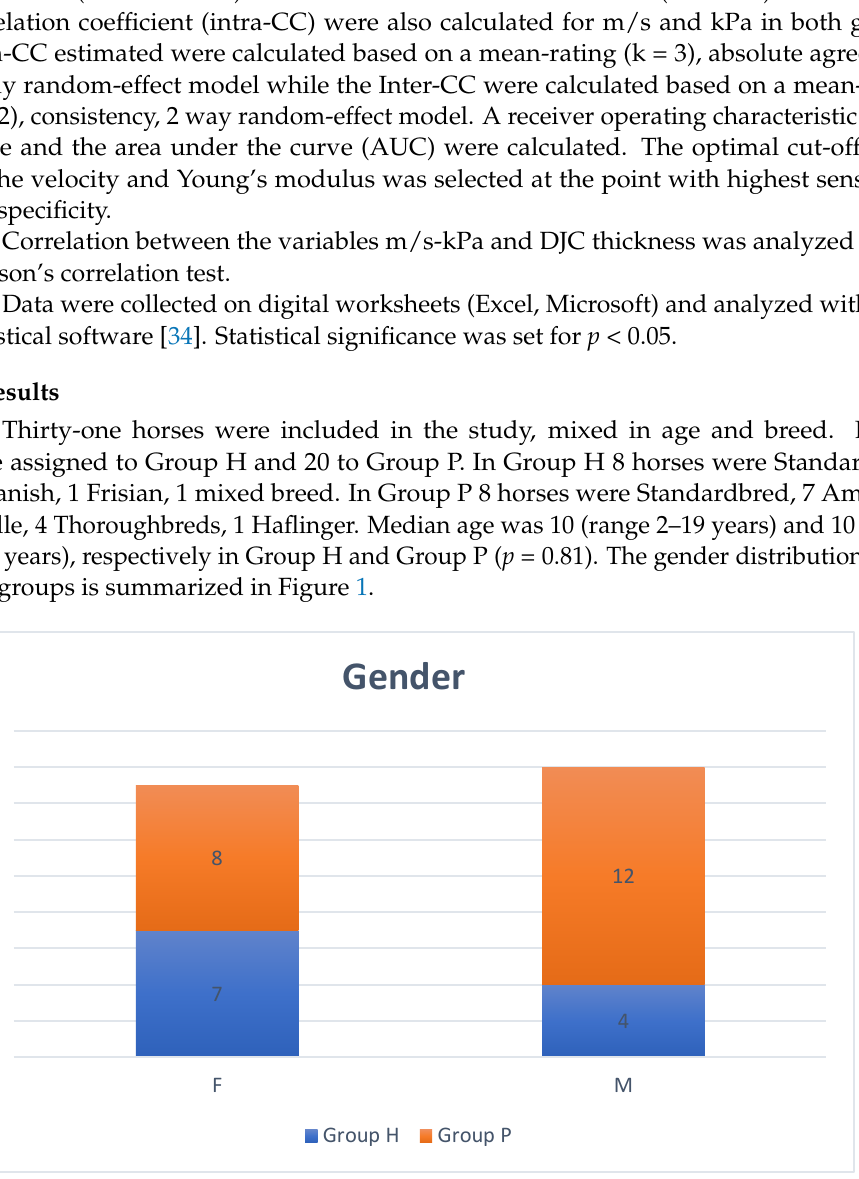
Figure 1. Gender distribution in Group H (blue) and P (orange) (F: female patients; M: male patients). In Group P, 11/20 (55%) horses had bilateral OA, 4/20 (20%) had right limb and 5/20 (25%) left limb